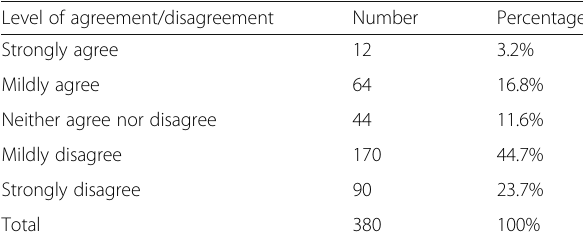
Table 5 Meat consumption negatively impacts on human